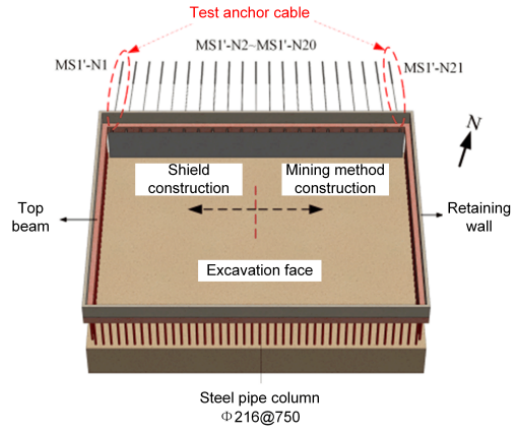
Figure 6. Construction position of test anchor cable.